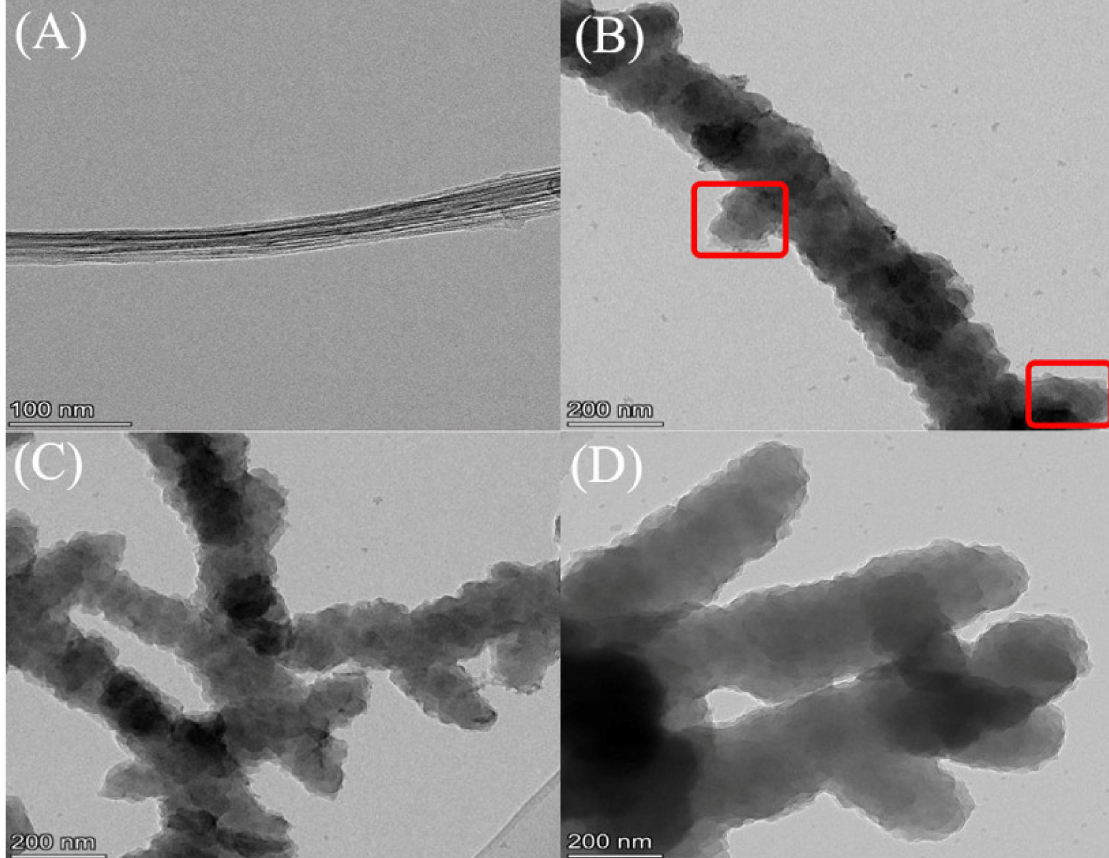
Figure 4. ( A ) TEM images of the acidified CNTF; ( B ) CNTF/PANI-5C; ( C ) CNTF/PANI-10C; and ( D ) CNTF/PANI-15C